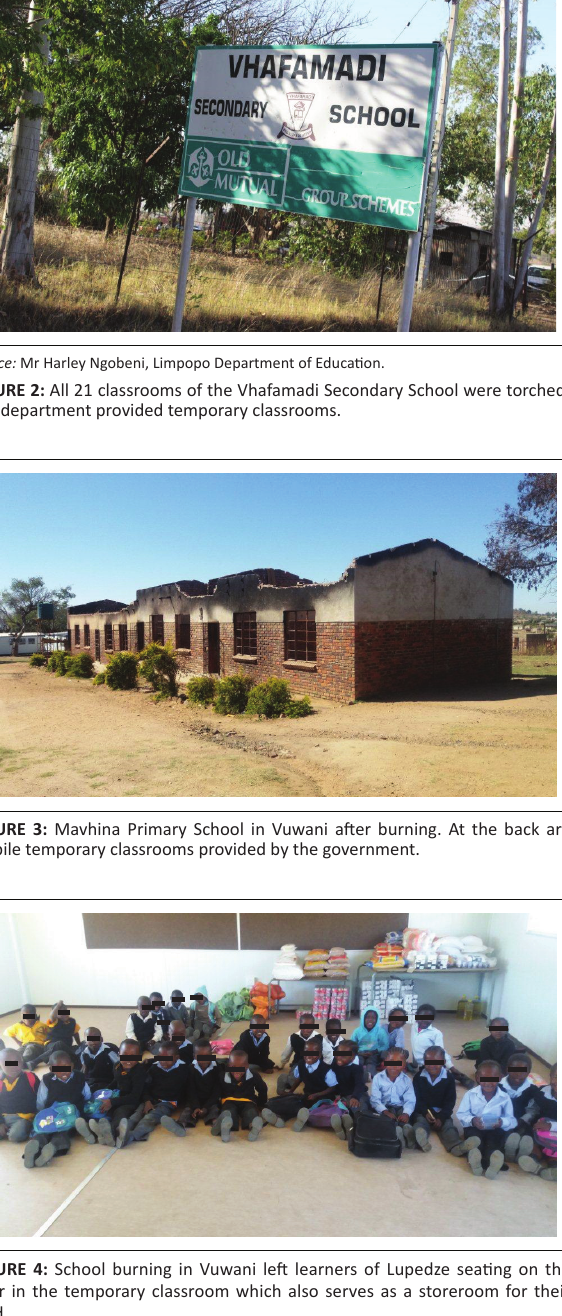
FIGURE 4: School burning in Vuwani left learners of Lupedze seating on the floor in the temporary classroom which also serves as a storeroom for their